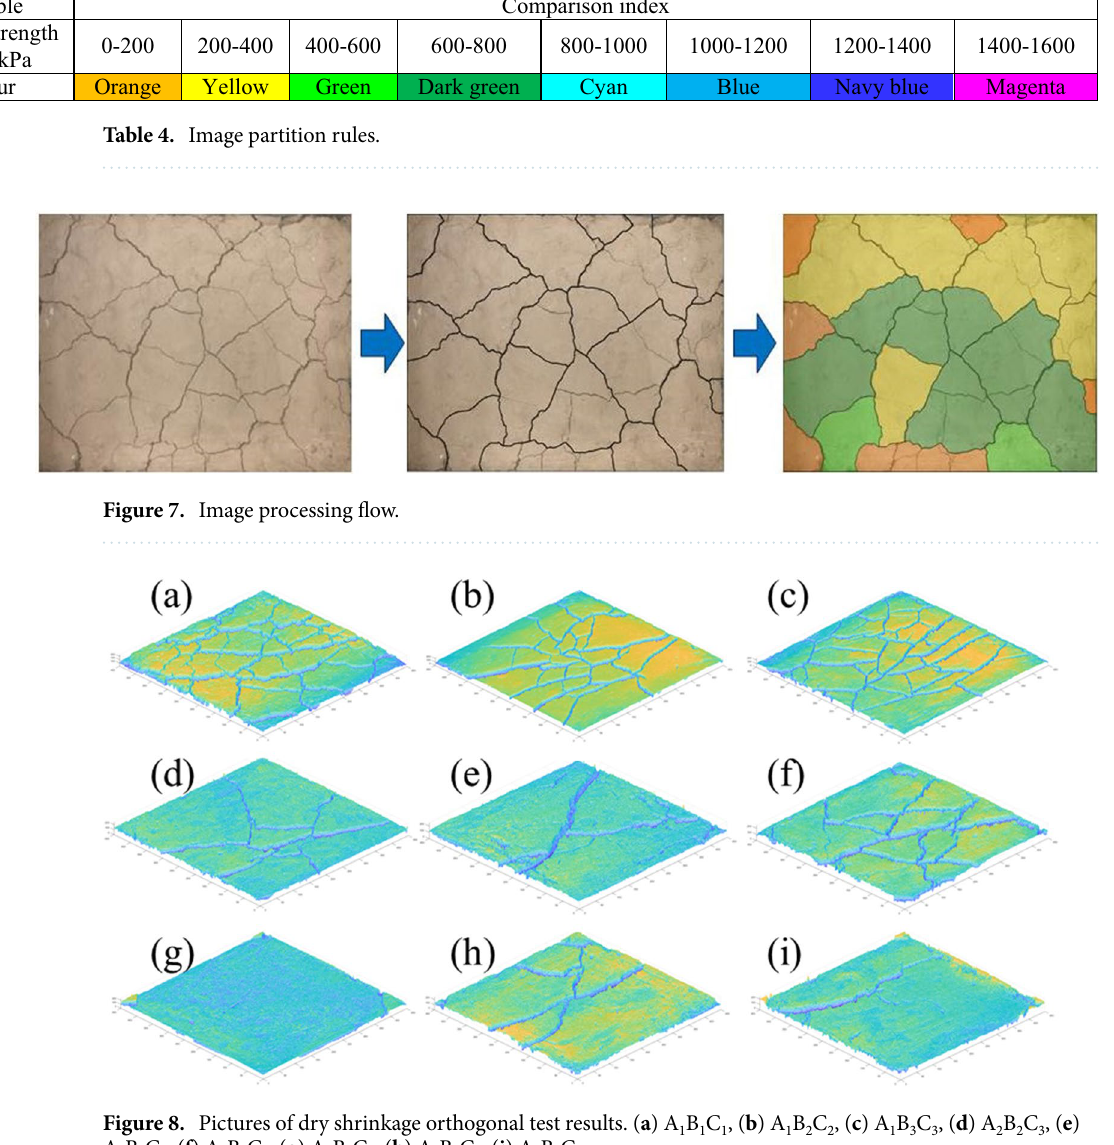
Figure 8. Pictures of dry shrinkage orthogonal test results. ( a ) A 1 B 1 C 1 , ( b ) A 1 B 2 C 2 , ( c ) A 1 B 3 C 3 , ( d ) A 2 B 2 C 3 , ( e )